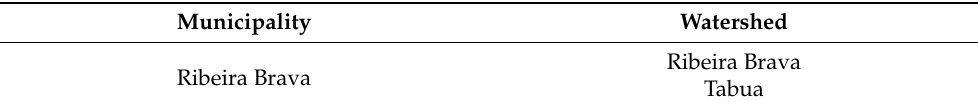
Table 11. Watersheds with high flood risk. (Source: